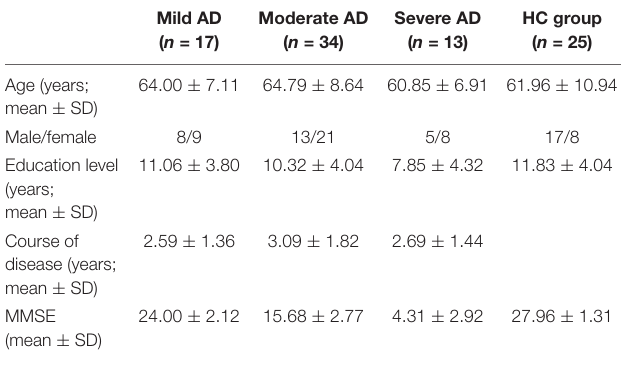
TABLE 1 | Clinical data of Alzheimer’s disease (AD) and healthy control (HC)